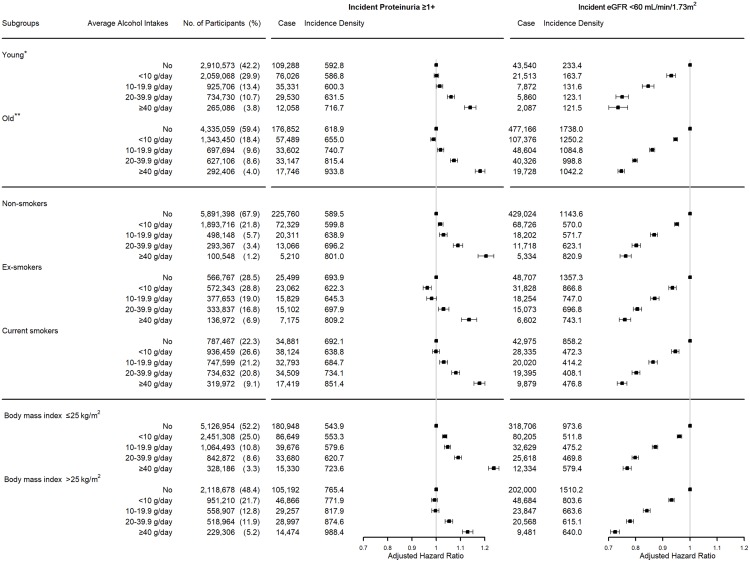
The association between alcohol intake and the risk of incident proteinuria and low estimated glomerular filtration rate (eGFR) in various subgroups.The old group was older than the sex-specific median age (44 years in men and 48 years in women). Incident proteinuria was defined as 1+ or higher spot urine dipstick test for proteinuria in the participants who showed a negative dipstick test at baseline. Incident low eGFR was defined as a decrease in eGFR <60 mL/min per 1.73 m2 in the participants who had eGFR ≥60 mL/min per 1.73 m2 at baseline. eGFR was calculated with the Chronic Kidney Disease Epidemiology Collaboration equation based on serum creatinine level. The risk was analyzed with an extended Cox model with alcohol intake level as a time-varying determinant, adjusted for baseline characteristics; age, sex, body mass index, systolic blood pressure, fasting serum glucose, serum high-density lipoprotein cholesterol and triglycerides levels, history of diabetes and hypertension medication, regular exercise, smoking status, and eGFR for incident proteinuria. Dots and error bars represent the adjusted hazard ratio and 95% confidence interval, respectively.